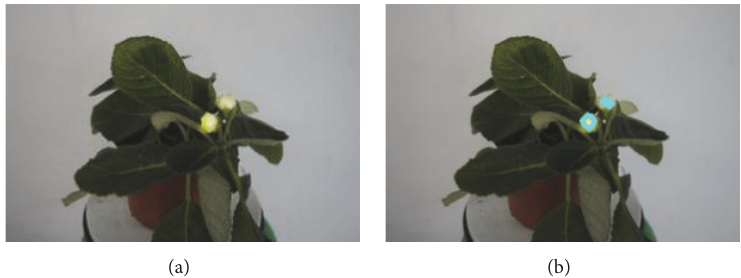
Figure 7: Example of bud detection. This figure shows the operation of bud detection. The buds in (b) are marked by aquamarine circle.